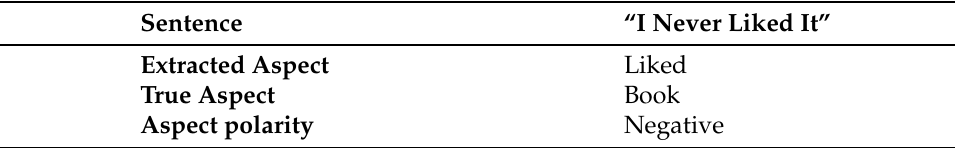
Table 4. Third type of error: wrong label. First